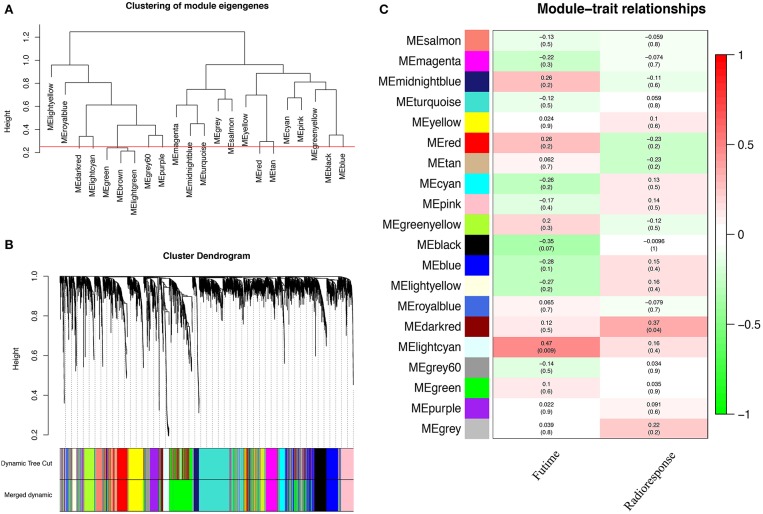
Identification of PCG modules associated with the radioresponse of PCa. (A) The horizontal line defines the threshold, so 20 distinct PCG modules are identified. (B) The dendrogram of all genes is clustered based on a dissimilarity measure (1-TOM). (C) The heatmap shows the correlation between MEs and the radioresponse of PCa. Red represents a positive correlation between PCG modules and clinical characteristics, and green represents a negative correlation between PCG modules and clinical characteristics.